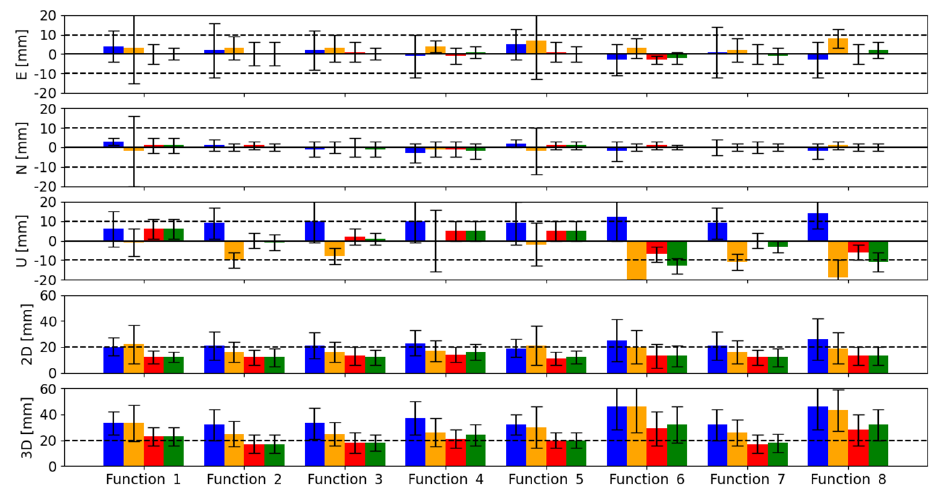
Figure 8. Mean accuracy with standard deviation from all stations and all periods for all analyzed weighting functions. Blue—E solution, orange—G solution, red—GE solution, green—GE1 solution. Slightly larger errors were obtained for the East component, which strongly depends and weighting functions. The exceptions are the Function_5 and Function_8 for the